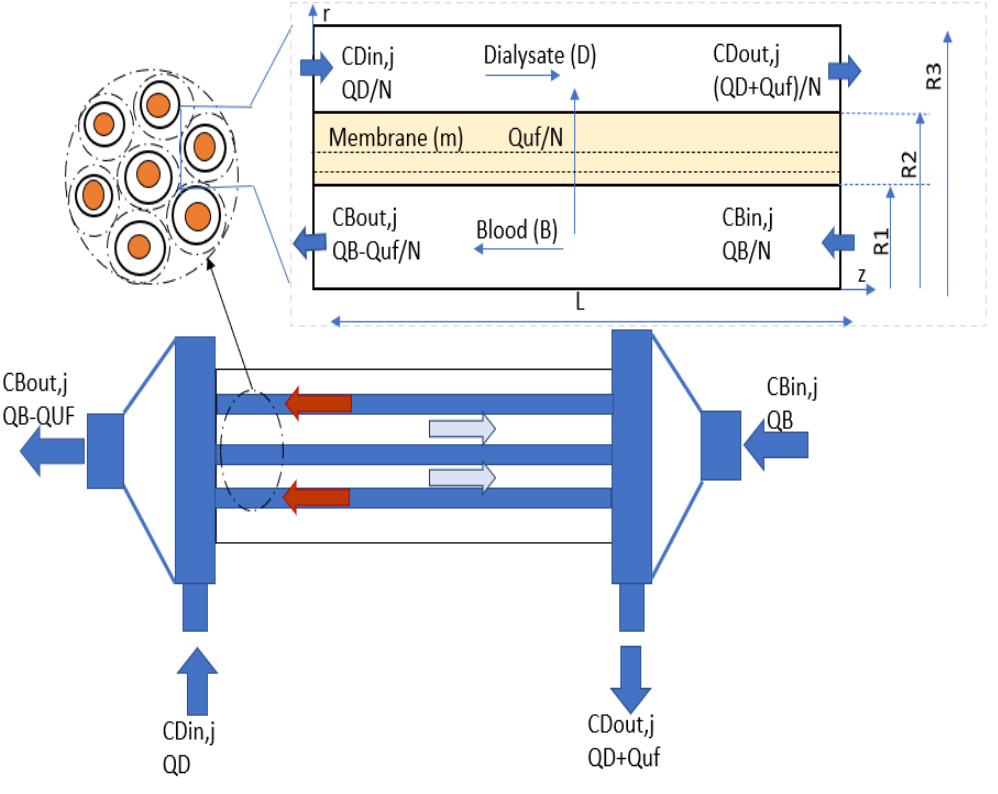
Figure 1. A framework of the geometry of the dialyzer module (lower panel) with its model developed in this work (upper panel). Table 1. Molecules that were examined in the computational analysis with their molecular weight [18] and diameter